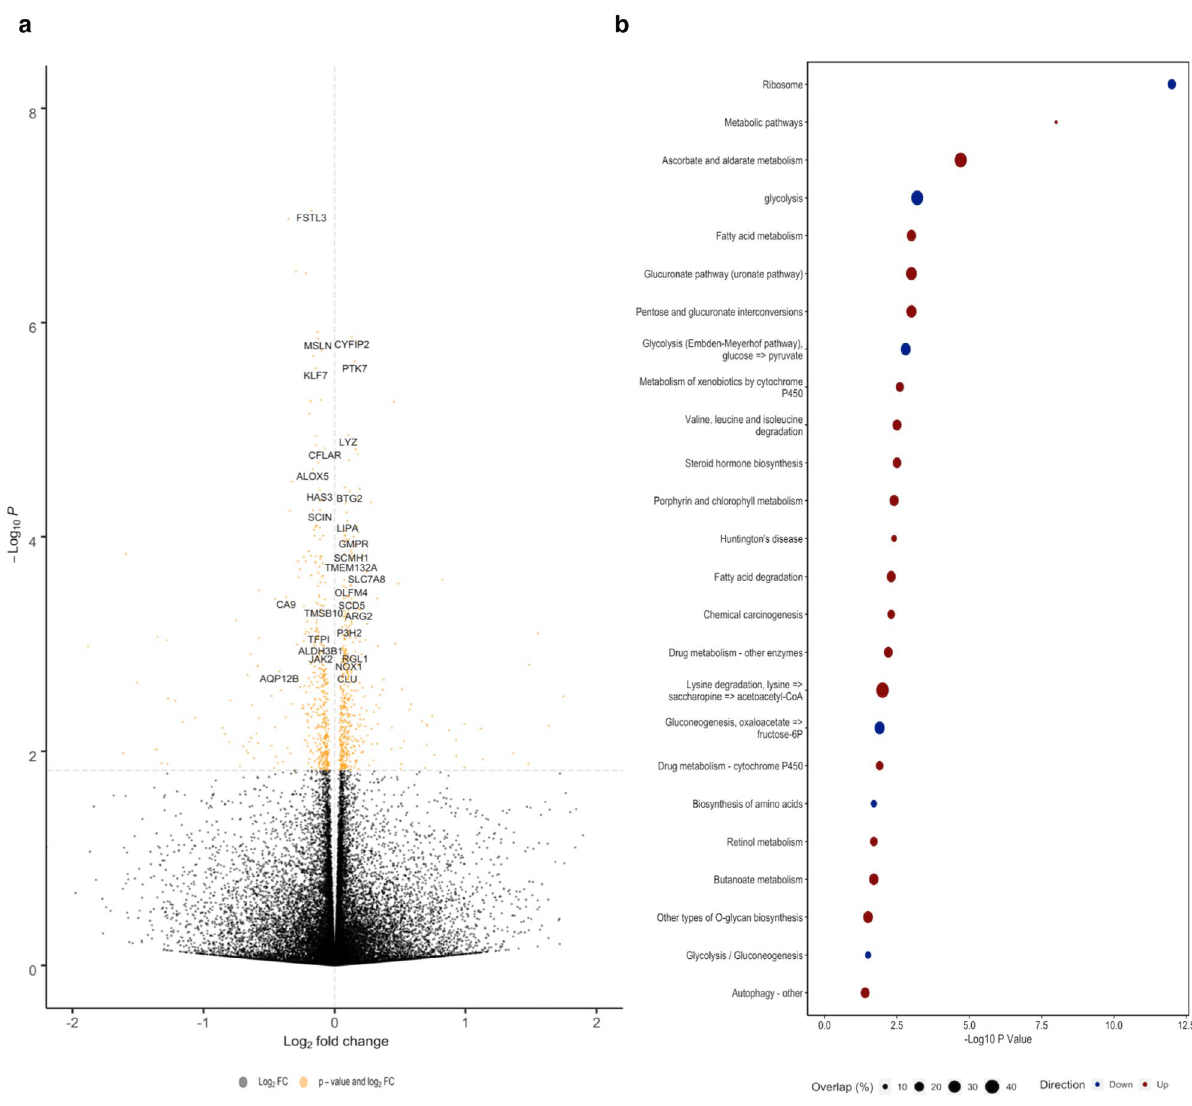
Figure 3. Summary of regression for cell-type agnostic approach. ( A ) Volcano plot of DEGs identified after adjusting for cell composition. Positive log fold change corresponds to increased expression in ethanol-treated organoids. ( B ) Results from pathway enrichment analysis of genes found to be nominally overexpressed (red) and underexpressed (blue) following ethanol treatment. Overlap indicated the percentage of DEGs found in gene list that comprise that